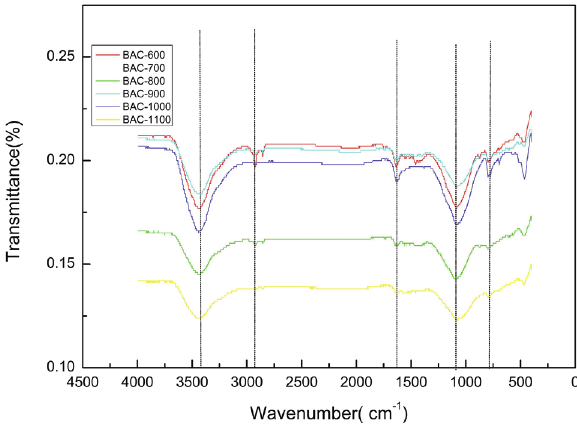
Figure 6: FTIR spectra of the